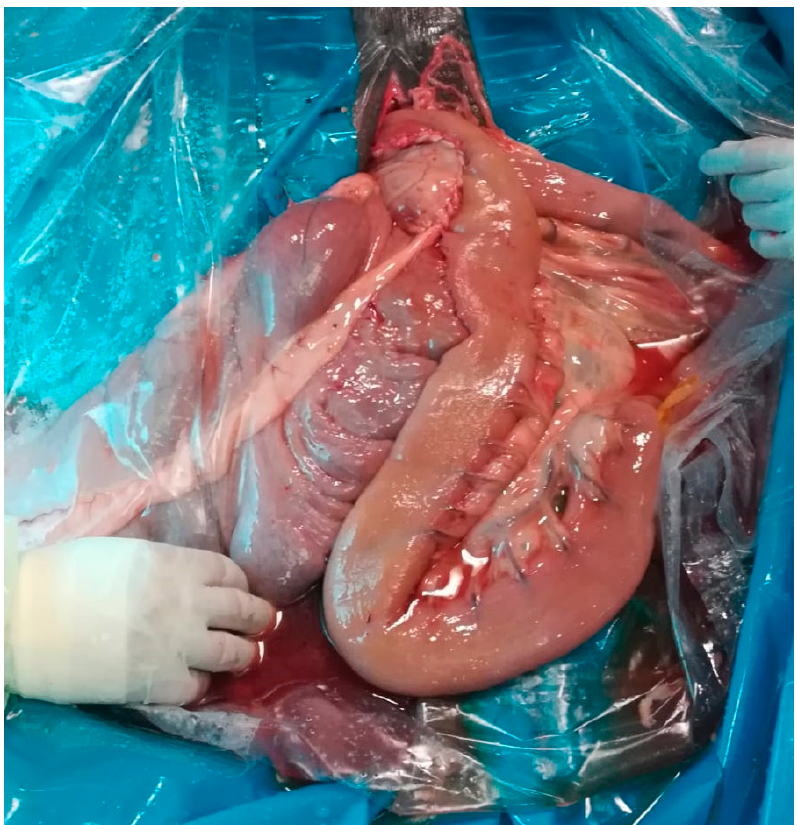
Figure 3. Incomplete ileocaecal bypass realized by hand-sewn